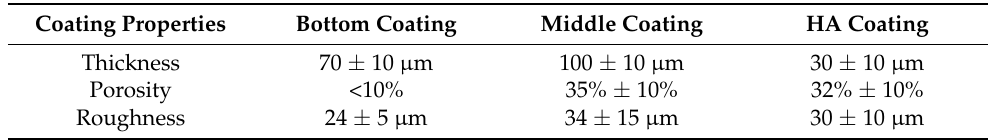
Table 2. Thickness, porosity, and surface roughness of the coating. Coating